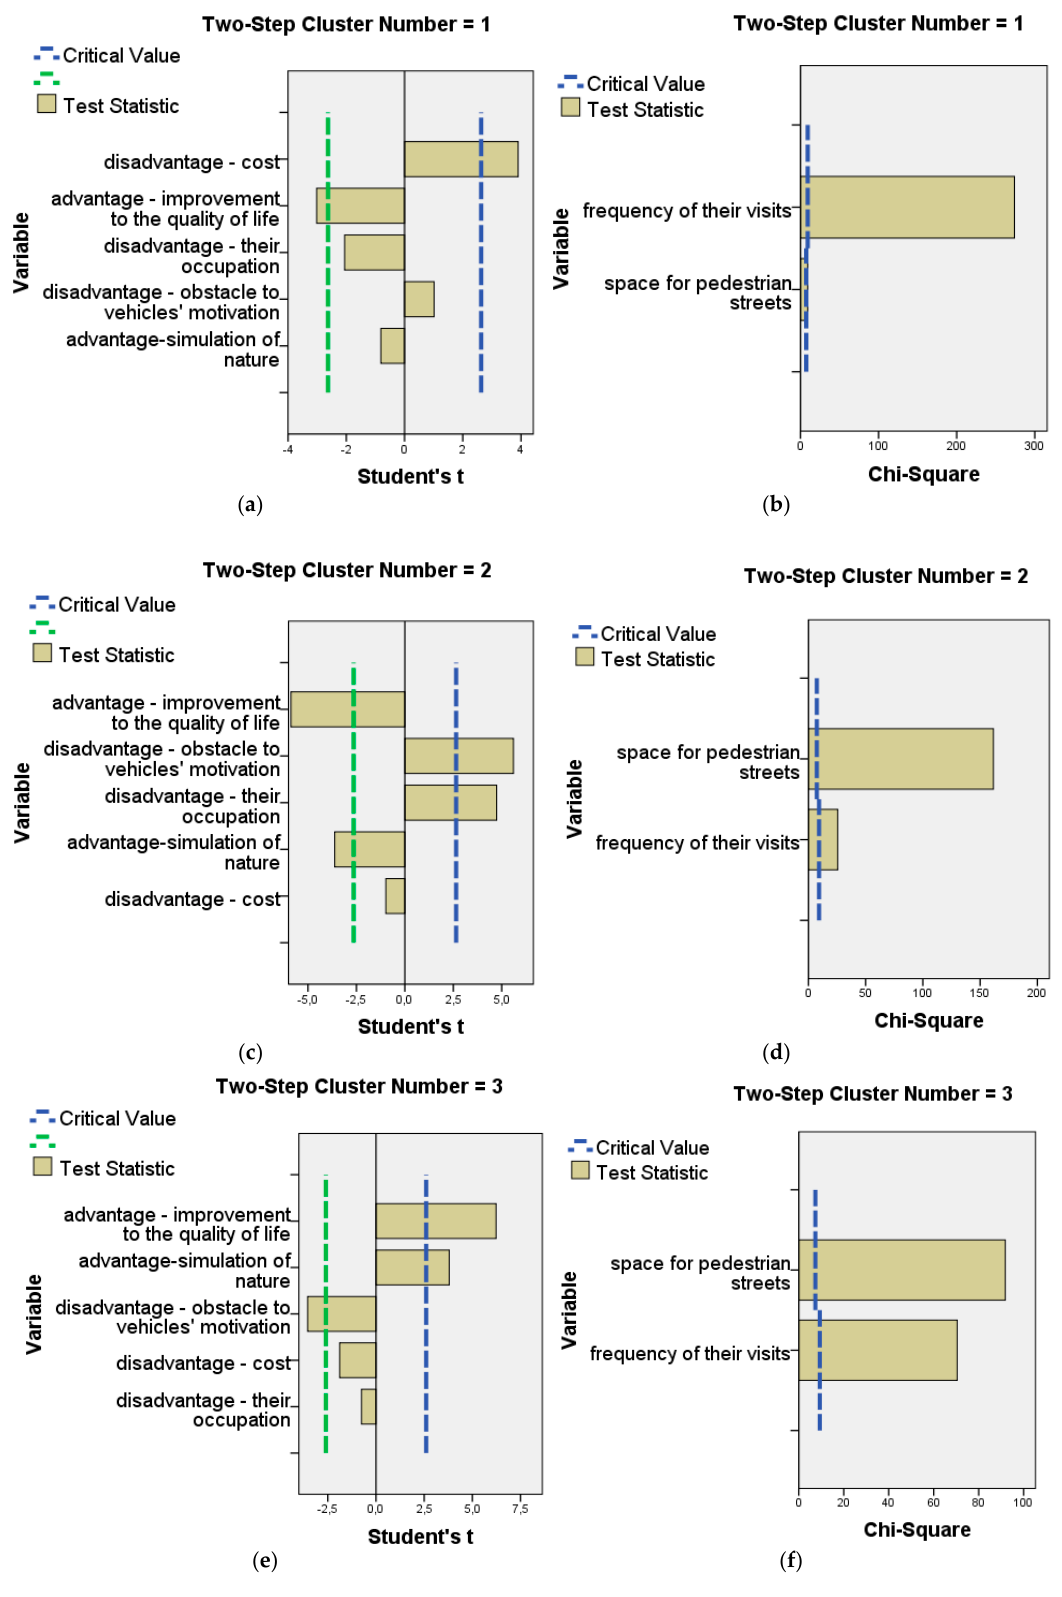
Figure 5. Diagrammatic representations of the statistical tests of variables per cluster ( a , c , e continuous and b , d , f categorical variables).